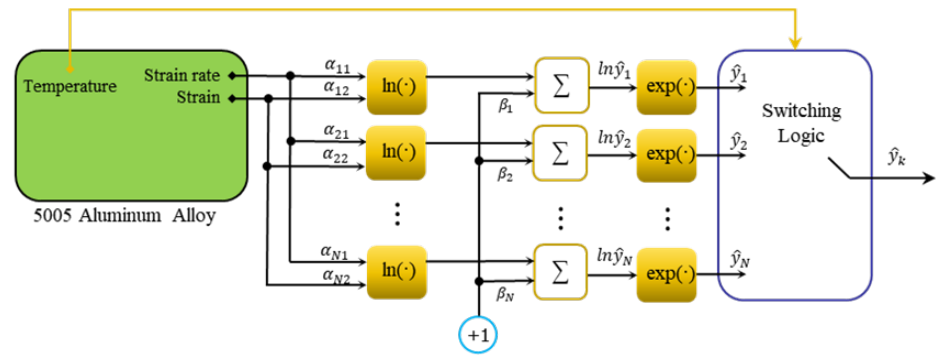
Figure 3. Schematic of the proposed multiple models with switching used to predict the stress of 5005 aluminum alloy.